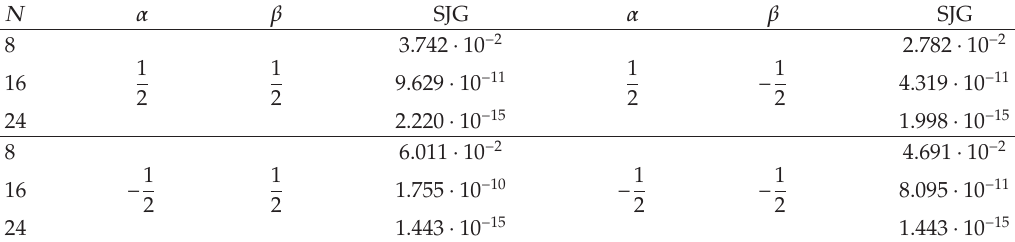
Table 3: Maximum pointwise error using SJG method for N (cid:9) 8 , 16 , 24 for Example 6.3. N α β SJG